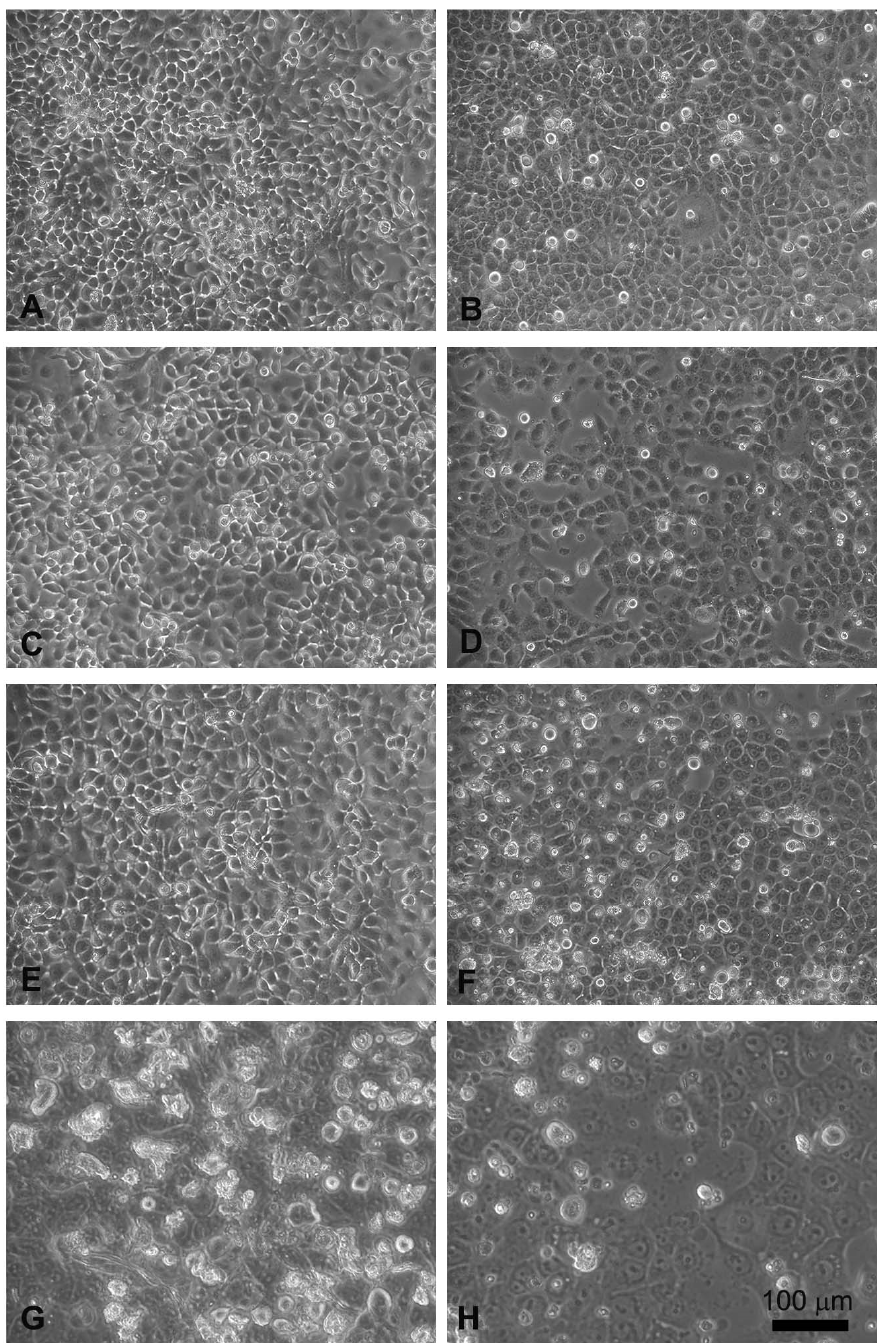
Figure 4. Morphological changes in FaDu cells (left panel) and CAL 27 cells (right panel) induced by EP and MMC after 24 h of treatment. ( A , B ) Control, no treatment; ( C , D ) single EP; ( E , F ) 5 µ M MMC; ( G , H ) combined treatment (EP + MMC).